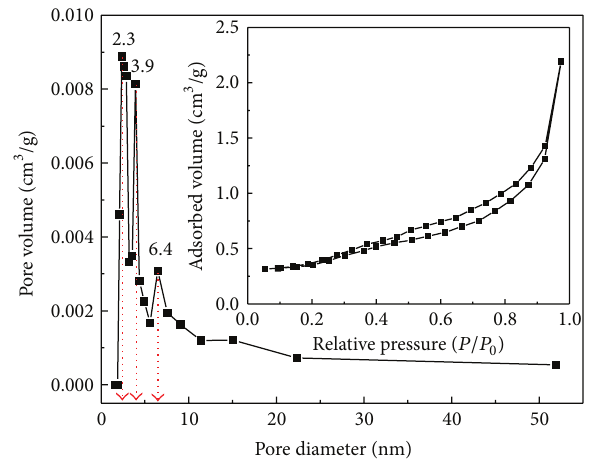
Figure 3: FT-IR spectra of the MEG samples.